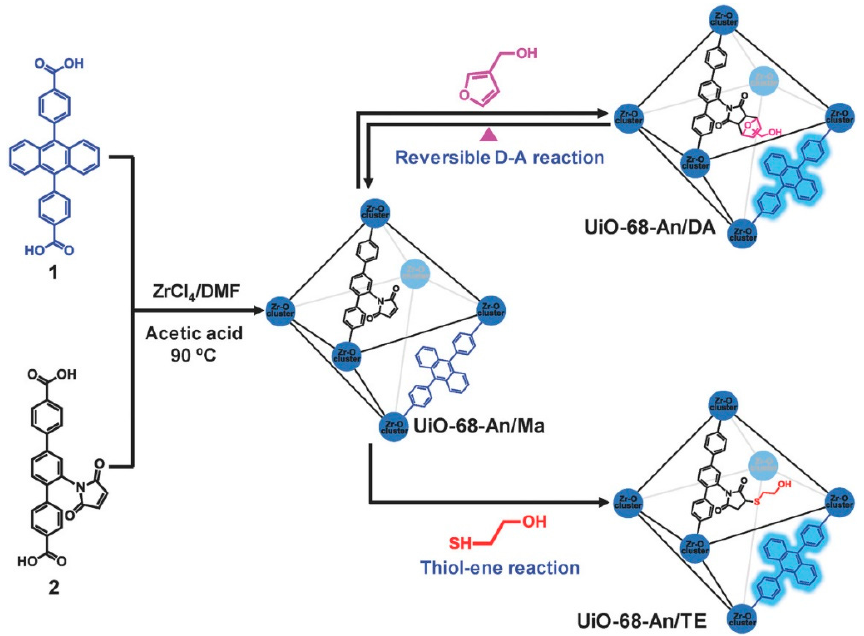
Figure 5. Synthesis of UiO-68-An/Ma and tuning the fluorescent PET in the MOF through the re- versible D–A reaction or thiol-ene reaction. The topology is shown in the simplified form as an oc- tahedral cage. Reprinted with permission from [98]. Copyright (2018) John Wiley and